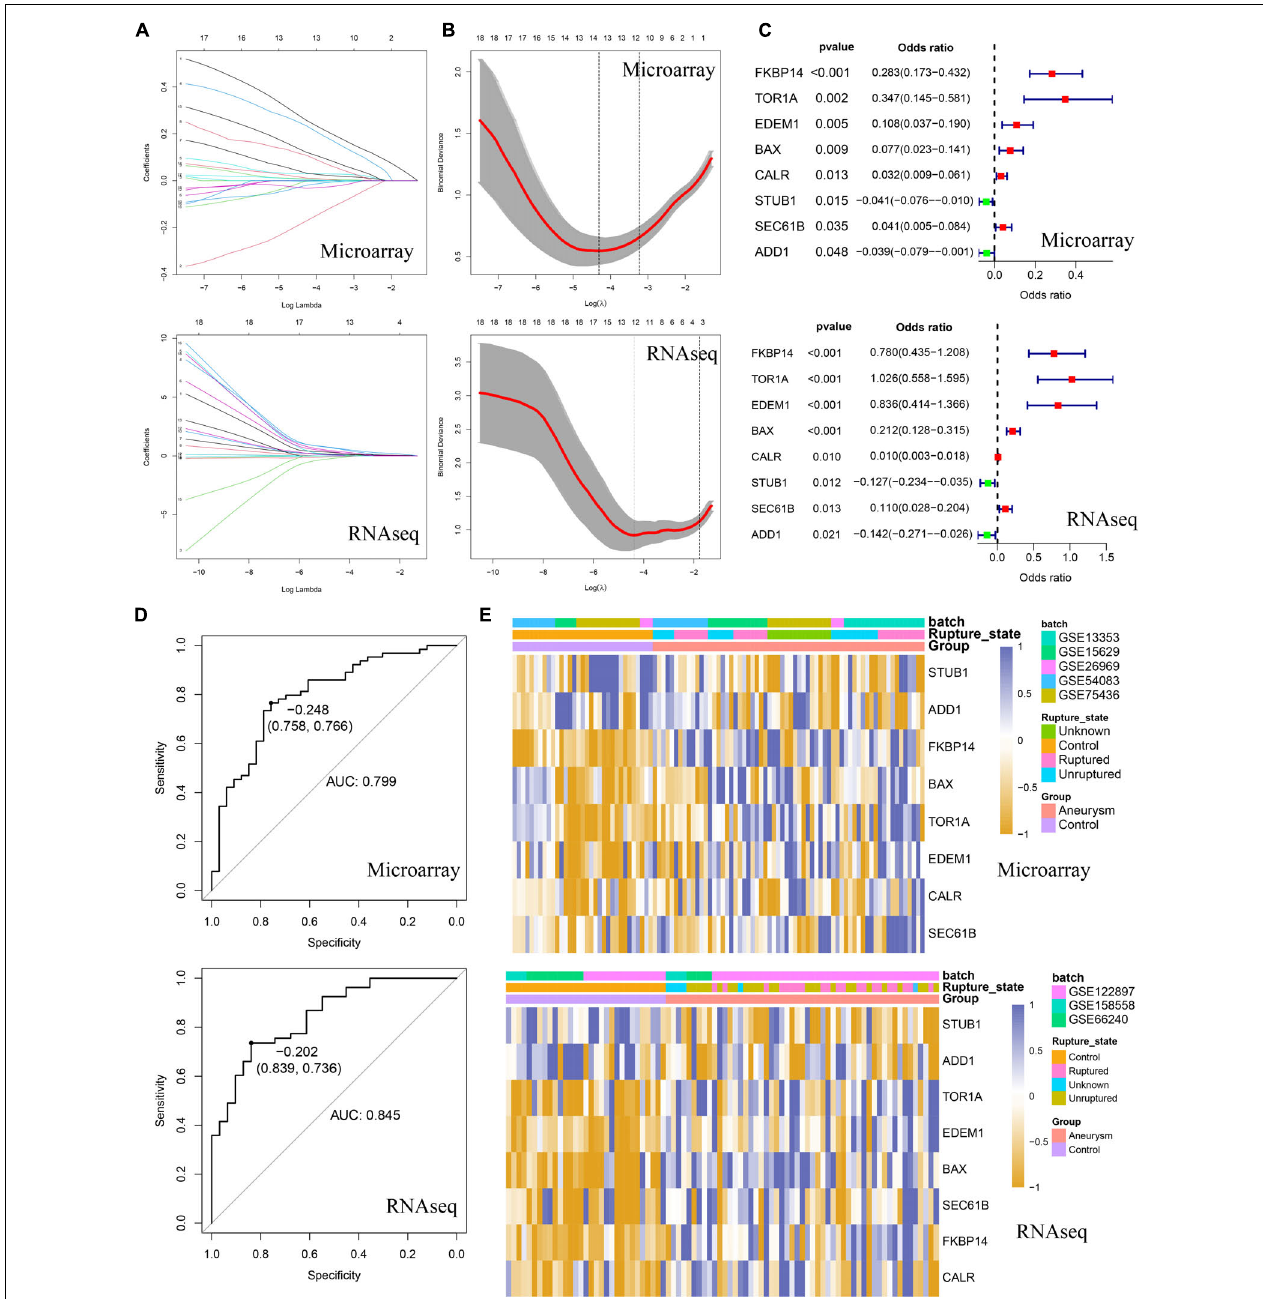
FIGURE 4 | Identification of the ERS-related signature in both training and validating cohorts. (A) The coefficient profiles of the LASSO regression model. (B) Cross-validation for tuning parameter screening in the LASSO regression model. (C) Univariate Logistic regression identified 8 ERS genes’ odds ratios (ORs) and 95% confidence intervals (Cls) after LASSO regression filtration. (D) ROC curve analysis for Gene Set Variation Analysis (GSVA) scores of 8 ERS genes. (E) The heatmap visualized the expression level of 8 ERS